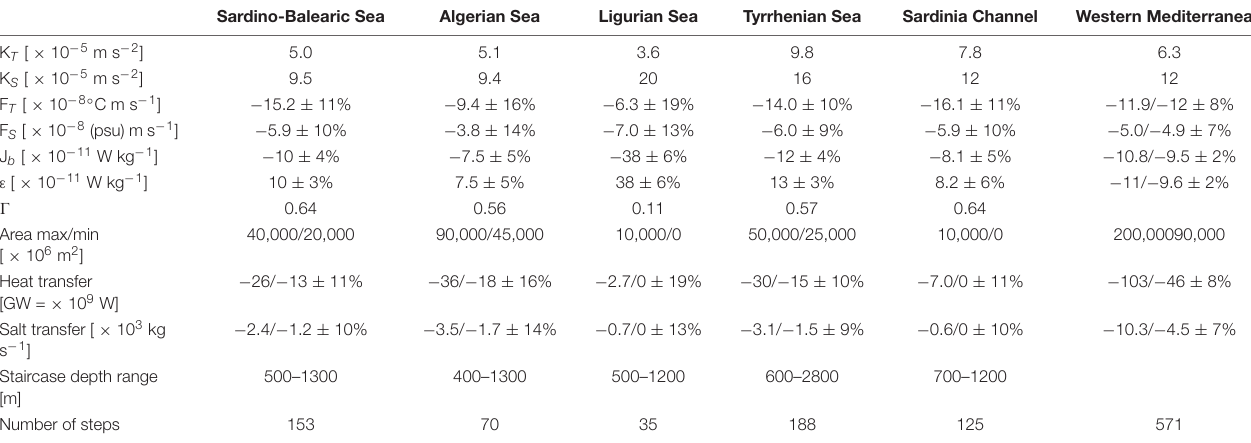
TABLE 3 | Salt fingering properties with regional averaged estimates of temperature (K T ) and salt (K S ) eddy diffusivities, temperature flux (F T ), salt flux (F S ), buoyancy flux